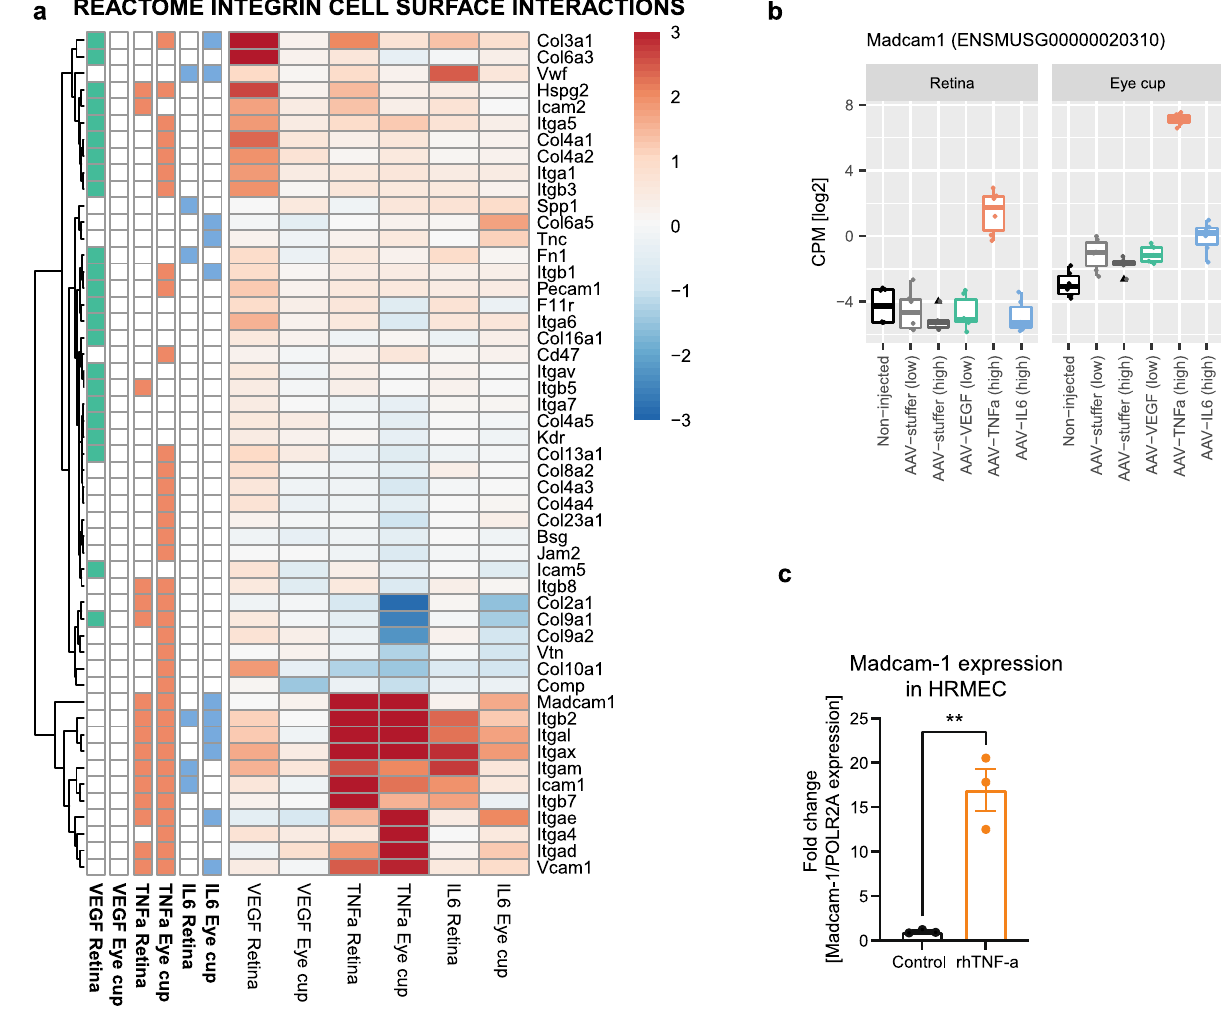
Figure 5. Cell adhesion molecules including Madcam-1 are specifically upregulated in AAV-TNF-α treated eyes. ( a ) Specific gene expression pattern within the REACTOME pathway “Integrin Cell Surface Interactions” revealed an upregulation of Collagen genes by AAV-VEGF. Left columns again indicate significant gene expression change with BH-adjusted P-value < 0.05. Members of the integrin family were mostly affected by AAV-TNF-α and AAV-IL-6 treatment, but not AAV-VEGF. ( b ) Madcam1 was one of the most upregulated genes in AAV-TNF-α injected eyes in both retina and eye cup tissue. ( c ) Human MADCAM1 expression is upregulated by TNF-α stimulation of human retinal microvascular endothelial cells (HRMECs, **p < 0.01, unpaired t-test, n =